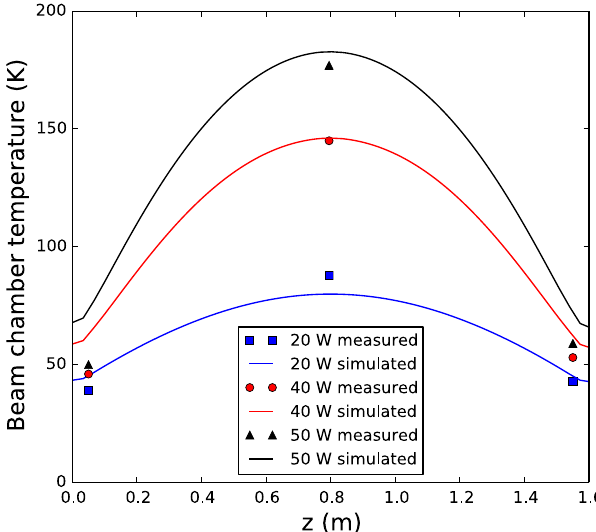
FIG. 21. Simulated and measured HSCU Al beam chamber temperature profile under different heat loads.